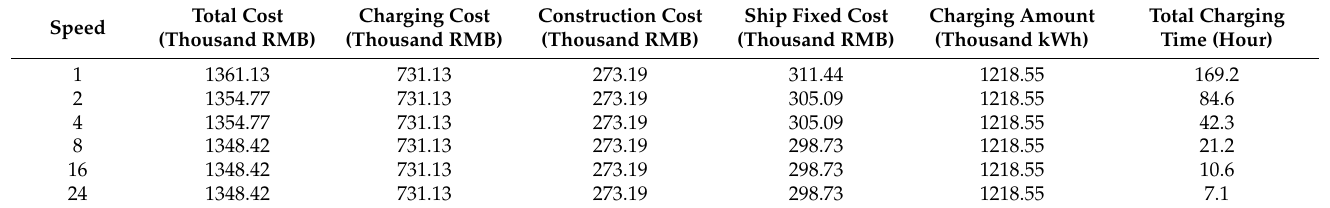
Table 10. The impact of charging speed.